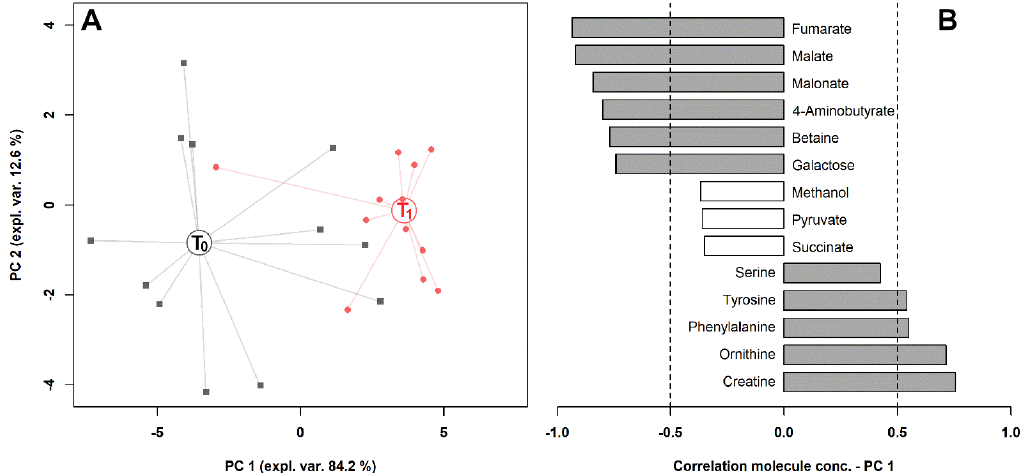
Figure 4. rPCA model built on the space constituted by the concentration of the molecules significantly different in saliva, listed in Table 2. ( A ) In the score plot, samples collected at T 0 and T 1 are represented with black squares and red circles, respectively. The wide, empty circles represent the median of the groups. ( B ) The loading plot reports the correlation between the concentration of each substance and its importance over PC 1. Significant correlations ( p < 0.05) are highlighted with gray bars.